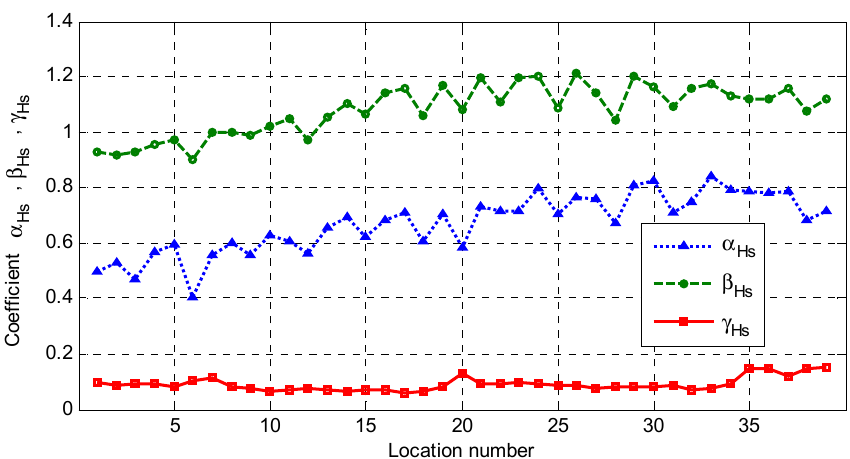
Figure 9. Model parameters for marginal distribution of significant wave height per location.